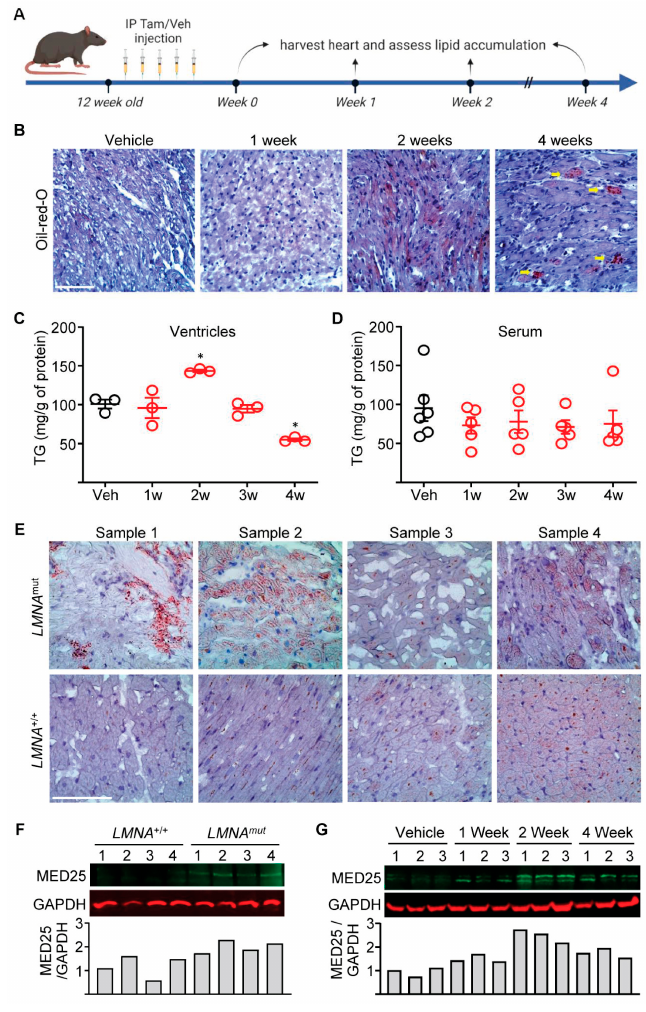
Figure 1. LMNA cardiomyopathic hearts accumulate lipids during disease pathogenesis. ( A ) Schematic of tamoxifen (Tam) administration schedule. Syringe denotes days of Tam injection. IP denotes intraperitoneal, Veh denotes vehicle (corn oil). ( B ) Oil-red-O staining of heart sections from CM-CreTRAP: Lmna flox/flox